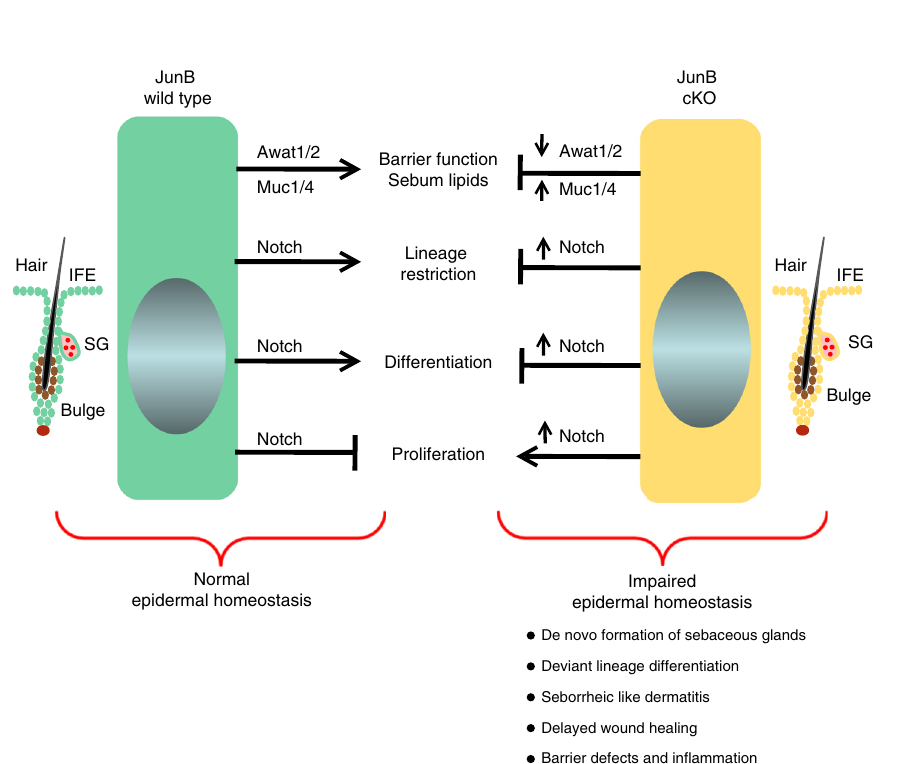
Fig. 7 Notch inhibition restored epidermal homeostasis in JunB cKOs. a Cartoon depicting experimental design and administration schedule of the Notch inhibitor DBZ or vehicle in JunB cKO mice. b Representative H&E staining and c immunostaining for the sebaceous gland speci fi c marker FABP5 demonstrates the absence of de novo sebaceous gland formation in newly formed wound epithelium of the Notch inhibitor DBZ treated JunB cKO mice as opposed to vehicle treated group ( n = 3). Scale bars, 50 µ m. d Representative microphotographs with immunostaining of differentiated keratinocytes marker K10 (red) and undifferentiated keratinocytes marker K14 (green), in DBZ treated JunB cKO mice compared to vehicle treated group ( n = 3). Nuclei stained with DAPI in blue. Scale bars, 50 µ m. e Representative microphotographs with immunostaining of proliferation marker Ki67 (green) and FABP5 (red) and f quanti fi cation, in DBZ treated JunB cKO mice as opposed to vehicle treated group. *** P < 0.001, t -test ( n = 3). Nuclei stained with DAPI in blue. Scale bars, 50 µ m. g TEWL, which is inversely related with epidermal barrier function, was measured on the dorsal skin of DBZ treated JunB cKO mice and vehicle treated group ( n = 3). *** P < 0.001, t